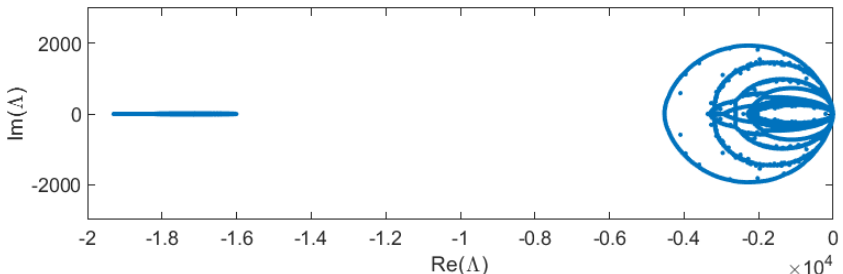
Figure 1. Eigenvalue Spectrum with a large spectral gap of eigenvalues ( Λ ).